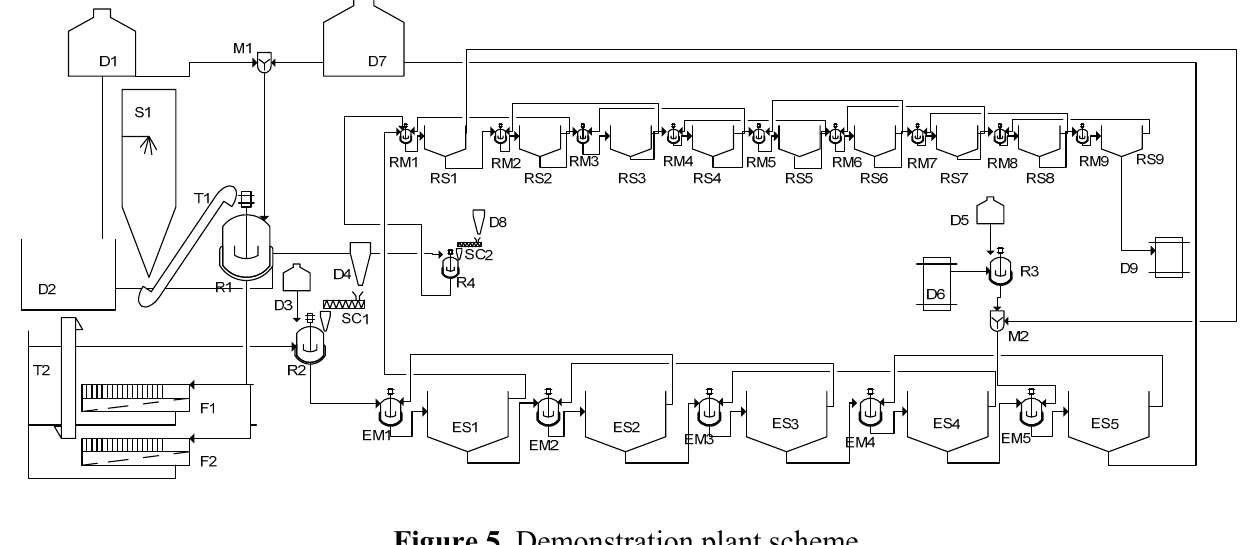
Figure 5. Demonstration plant